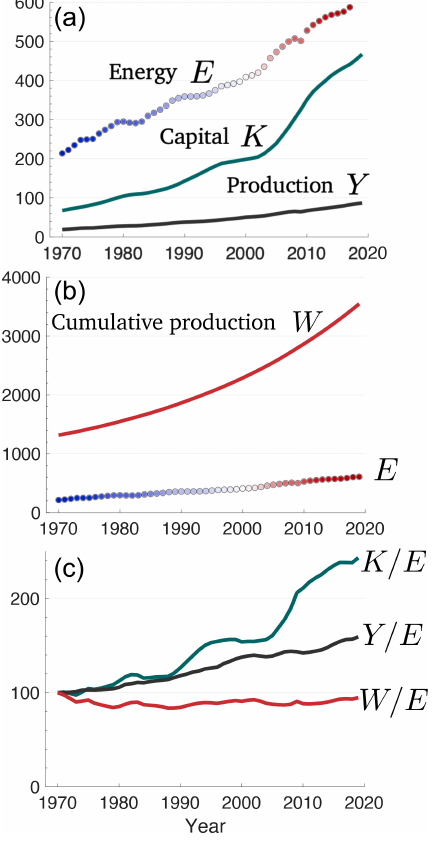
Figure 2. (a) Time series for the period 1970 to 2019 of global yearly annual primary energy consumption E i in EJyr − 1 , the world annual GDP Y i in yearly currency, and the total value of physical capital stock K i in units of currency. (b) Energy in EJyr − 1 and historically cumulative production W i in currency. (c) The ratio of economic values to annual energy consumption, setting the ratio in 1970 to 100. All currency units are in trillions of 2019